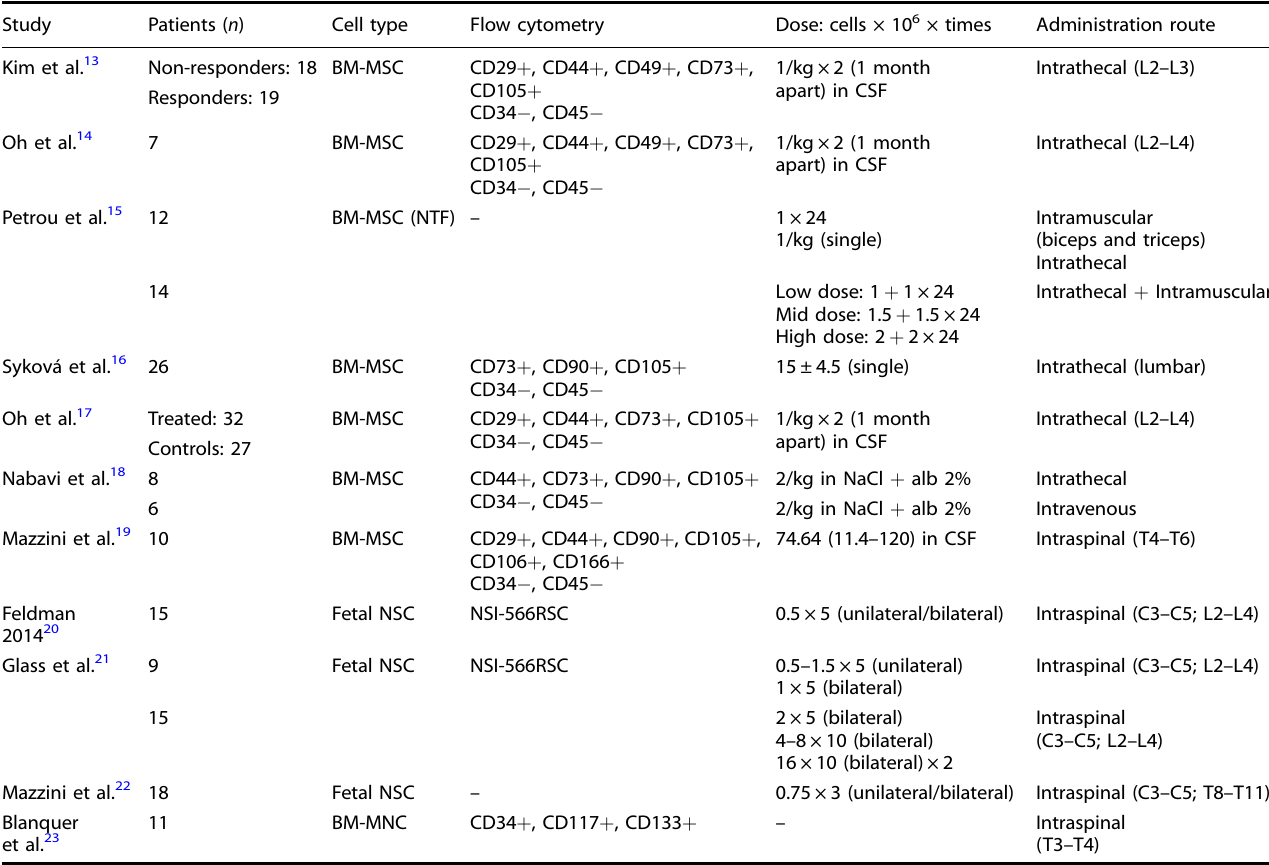
Table 1. Clinical trials included in the